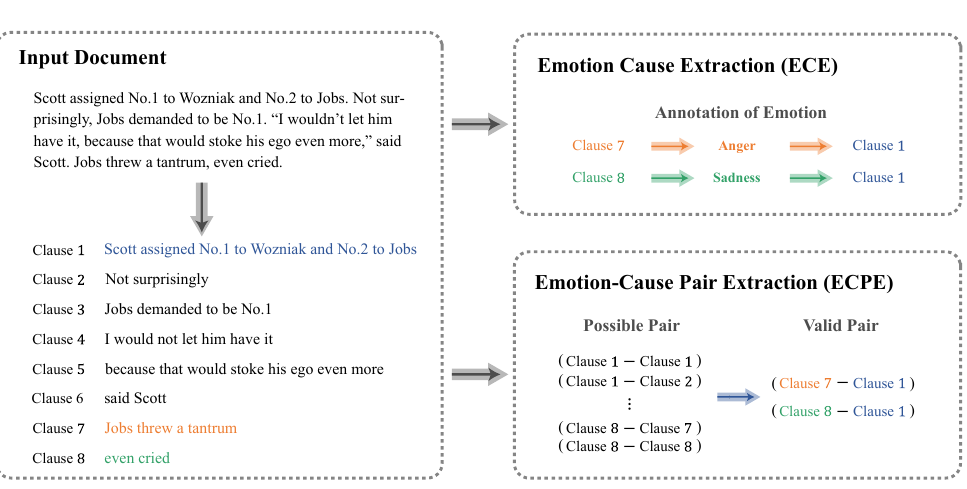
Figure 1. The difference between ECE tasks and ECPE tasks. ECE task aims to extract each cause clause provided emotion annotation, while the ECPE task is targeted at extracting all valid pairs of emotion clauses and the corresponding cause clause in an input document. The orange and green parts are emotion clauses, and the blue is a cause